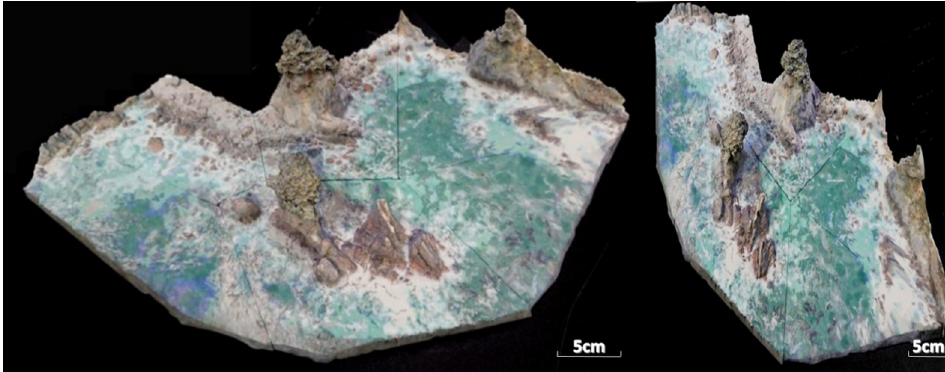
Figure 15. Three-dimensional model printed using a Z Corp. Z250 printer.